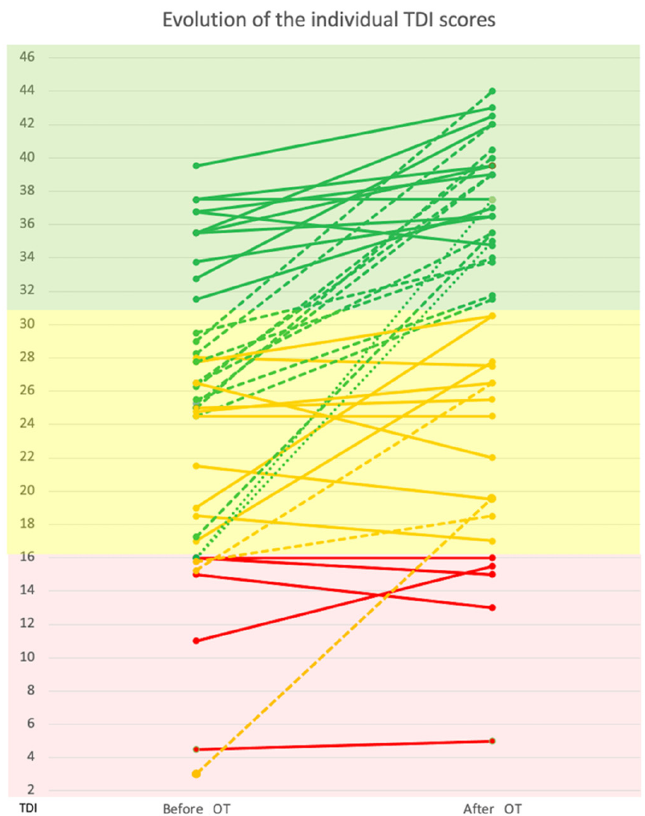
Figure 1. The evolution of individual TDI scores (from the SST) before and after olfactory training (OT). Colored parts cover anosmic (red), hyposmic (yellow) or normosmic (green) patients according to TDI normative values [20]. Oblique lines represent a patient anosmic (red), hyposmic (yellow) or normosmic (green) subject evolution according to post OT olfactory evaluation. Solid, dashed or pointed lines represent, respectively, patients who did not change category, changed to the upper category or changed from the anosmic to normosmic category.